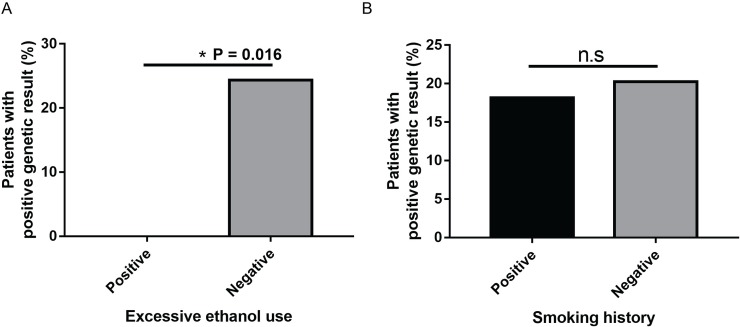
Relationship between excessive ethanol use or smoking and the detection of a likely pathogenic or pathogenic variant.(A) Percentage of patients who have a likely pathogenic or pathogenic variant given that they are excessive drinkers or are not excessive drinkers. Patients that report excessive ethanol consumption have a lower chance of possessing a positive genetic variant, whereas those that do not excessively drink have a higher positive detection rate (24.4%) (OR, 0–0.70; *, p = 0.016; CI = 95%). (B) Percentage of patients who reported to have smoked in the past/currently or have never smoked that have a likely pathogenic or pathogenic variant (OR, 0.29–2.78; p = 0.829; CI = 95%).